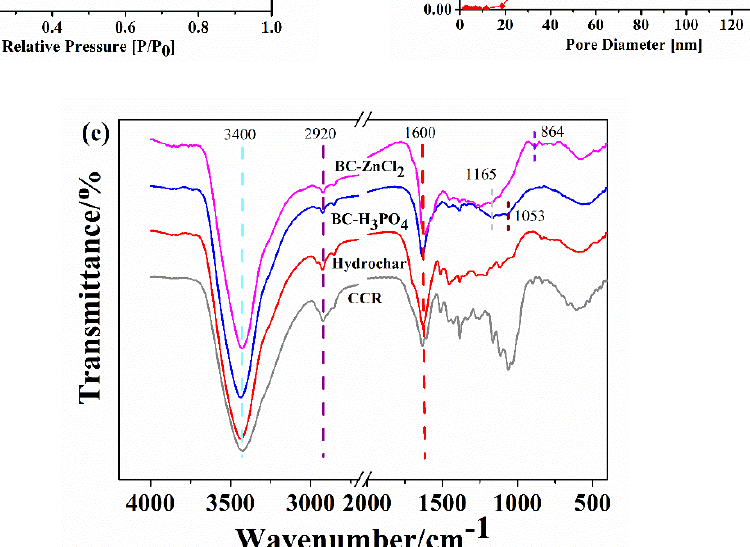
Figure 4. Scanning electron microscopy (SEM) images of ( a ) 500× Hydrochar; ( b ) 5000× BC-H 3 PO 4 ; ( c ) 5000× BC-ZnCl 2 .